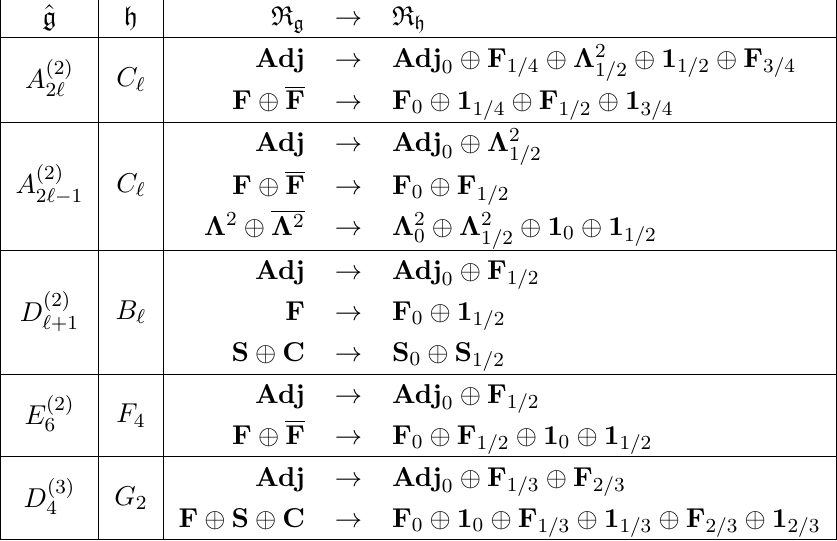
Table 34. Summary of KK-momentum shifts on each representation under twisted compactifi- cation. When ˆ g = X ( r ) , R g and R h denote representation in g = X ‘ and h , respectively. The ‘ subscript in the representations of R h denotes KK-momentum